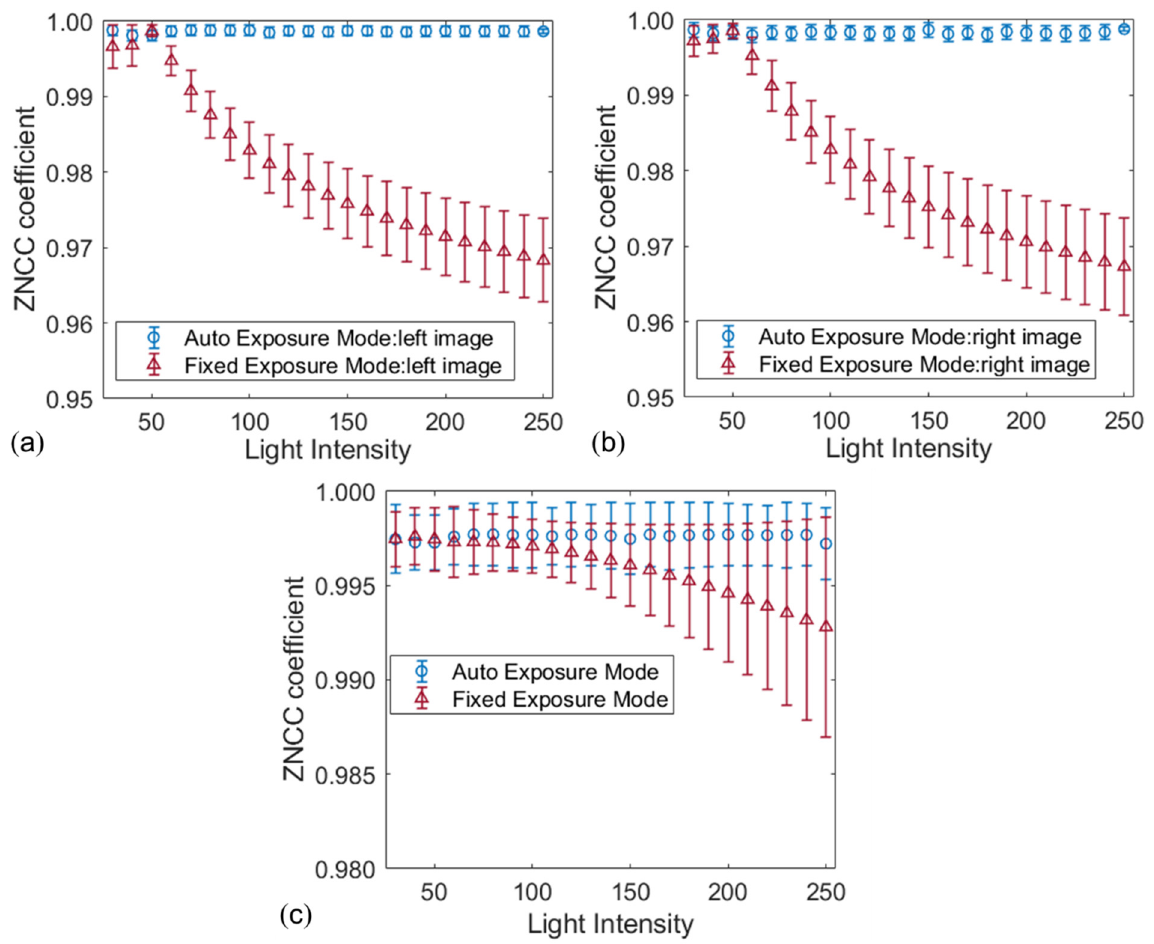
Figure 7. The calculated ZNCC coefficients of temporal matching result in ( a ) left image sequence and ( b ) right image sequence; ( c ) stereo matching results at different light intensities.